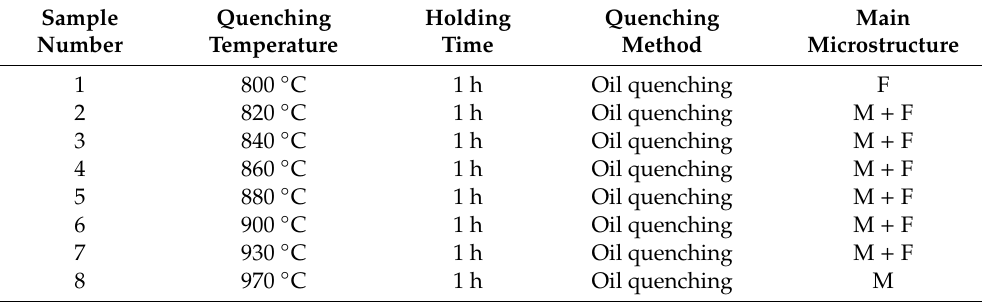
Table 2. Quenching treatment in experiment.